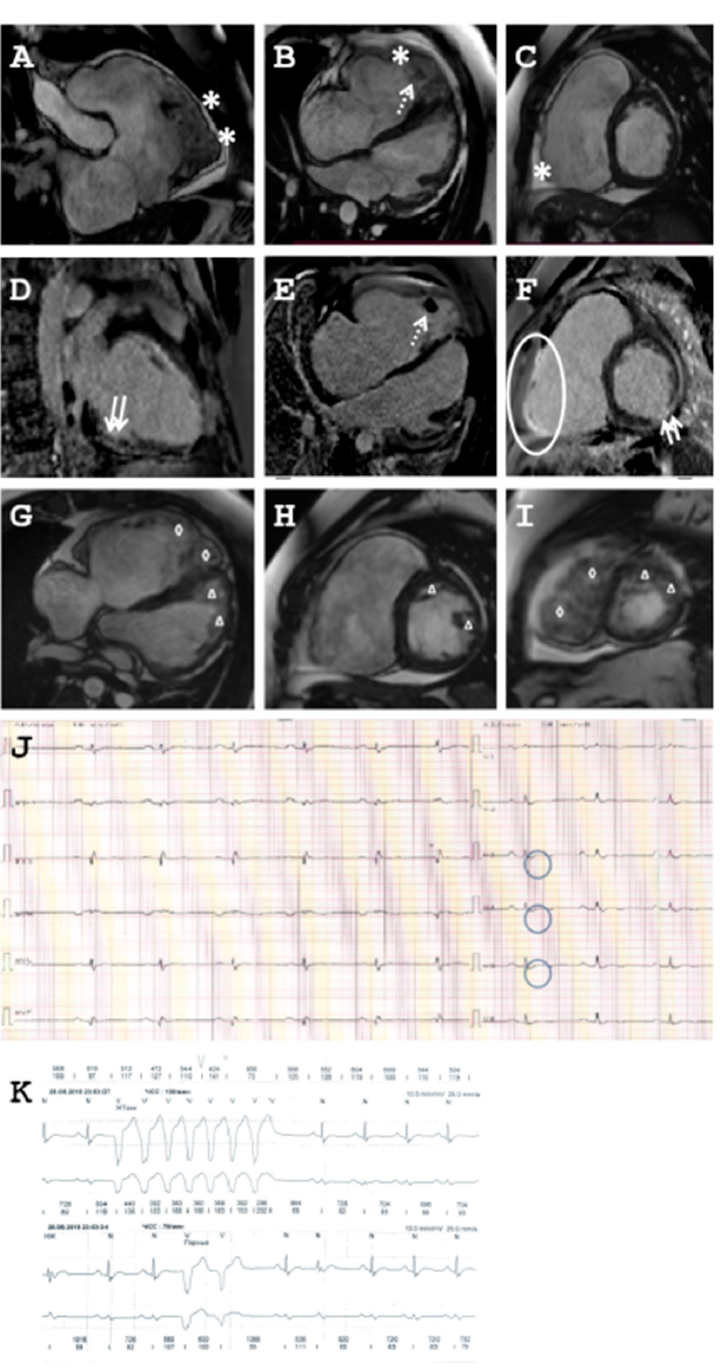
Figure 4. Clinical data of Family B. ( A–I ) Cardiac magnetic resonance imaging (MRI) of index patient (II-2, Family B). Asterisk indicates thinning and aneurysmal protrusion of right ventricular wall ( A–C ). Arrows indicate ischemic changes in left ventricle ( D, F ). Dotted arrows indicate thrombosis in the right ventricle ( B, E ). Ellipse shows fibrosis of the right ventricle ( F ). Triangle demonstrates LV non-compaction ( G–I ). Rhombus demonstrates RV non-compaction ( G, I ). ( J ) Epsilon waves were present in the 12-lead ECG. ( K ) Tachycardia was present in the Holter moni- toring-ECG.